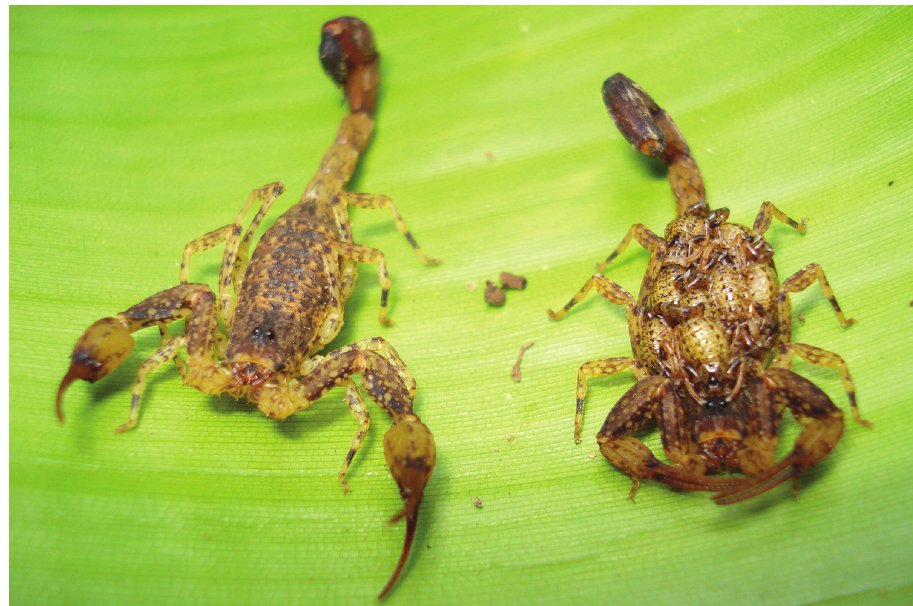
Figure 14. Tityus silvestris , male (left) and female with juveniles (right) from Saül (photo A.